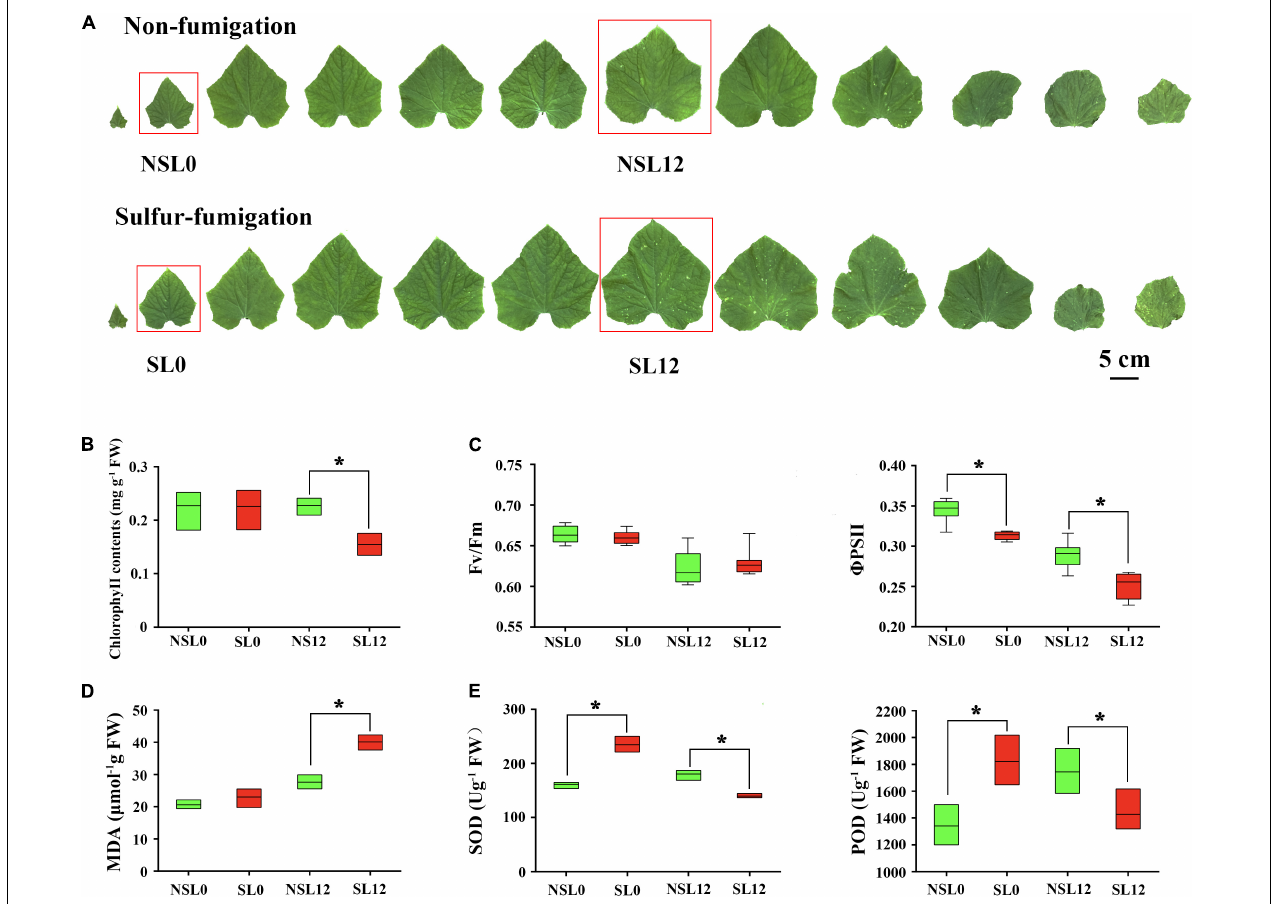
FIGURE 1 | Effects of sulfur (S) fumigation on (A) the appearance of leaves, (B) chlorophyll contents, (C) Fv/Fm and (cid:56) PSII, (D) MDA, and (E) SOD and POD. * indicates significant difference at P < 0.05, according to Duncan’s test.